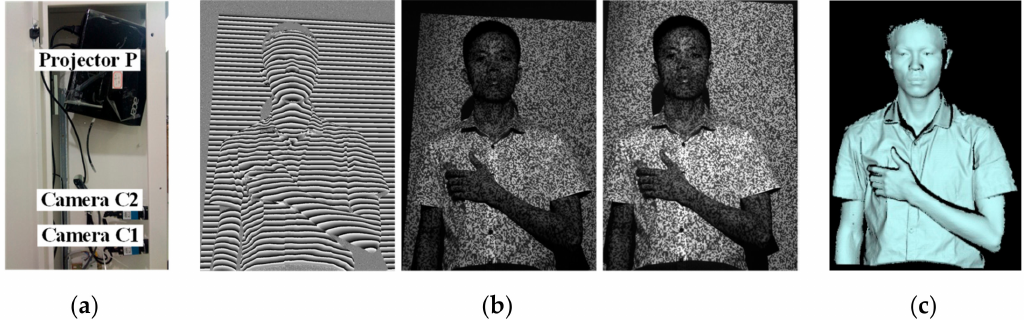
Figure 8. Figure 8. ( a ) Sketch of the system; ( b ) wrapped phase and pseudorandom images; ( c ) rebuilt 3D